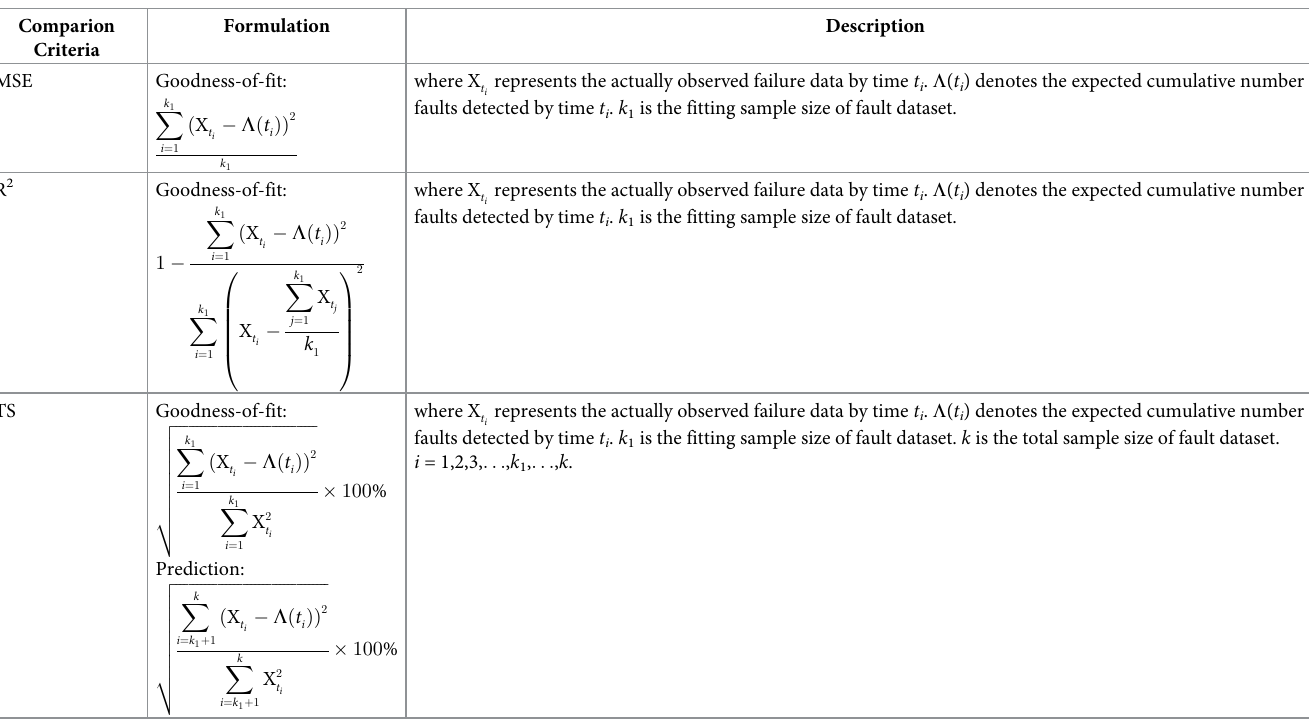
Table 1. Model comparison criteria for